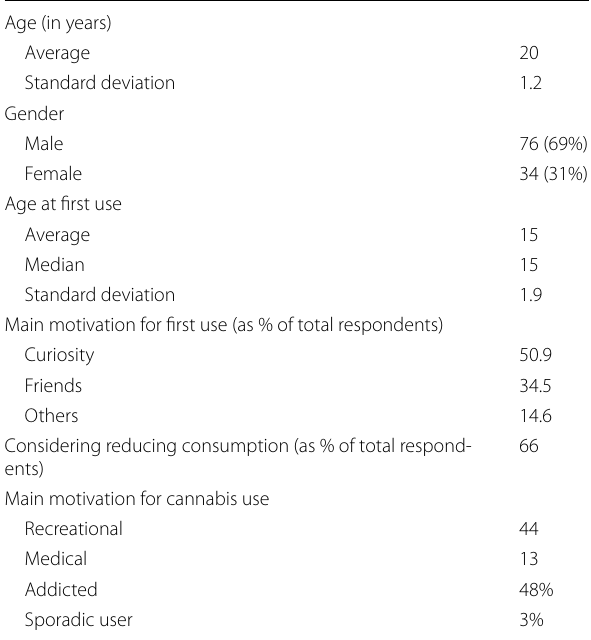
Table 1 Demographic and cannabis use characteristics of